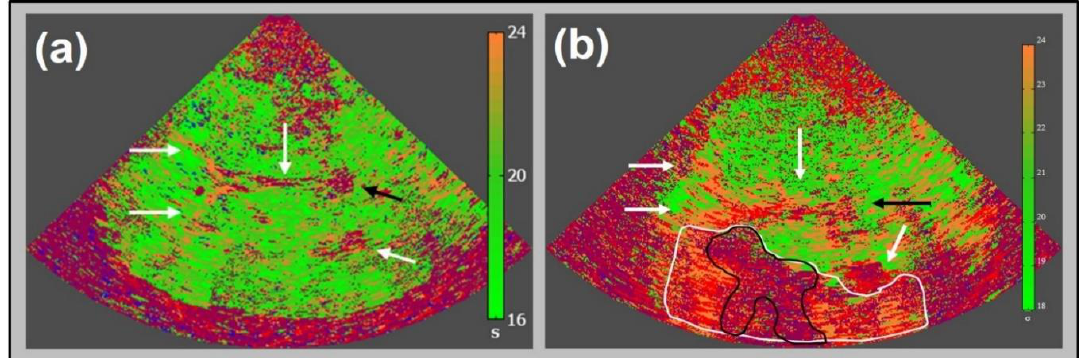
Figure 3. Up to date “ bilateral ” perfusion imaging corresponding to Figure 1: parametric image of time-to-peak intensity (TPI) in a healthy volunteer ( a ) with homogeneously distributed greenish parts of parenchymal structures (TPI 16 to 20 s) and the depiction of frontal and posterior horns of side ventricles as well as third ventricle (white arrows), and pineal gland (black arrow), adapted from [12]. Note the near field artifact. TPI parameter image of an acute stroke patient 2.5 h after symptom onset ( b ) of a severe stroke caused by occlusion of the M1 segment of the middle cerebral artery. Note the core of infarction (pink area, surrounded by black line) and hypo-perfused nature, and potentially salvageable area (orange area, surrounded by white line) due to collateral flow; adapted from [12] with the publisher ’ s permission.